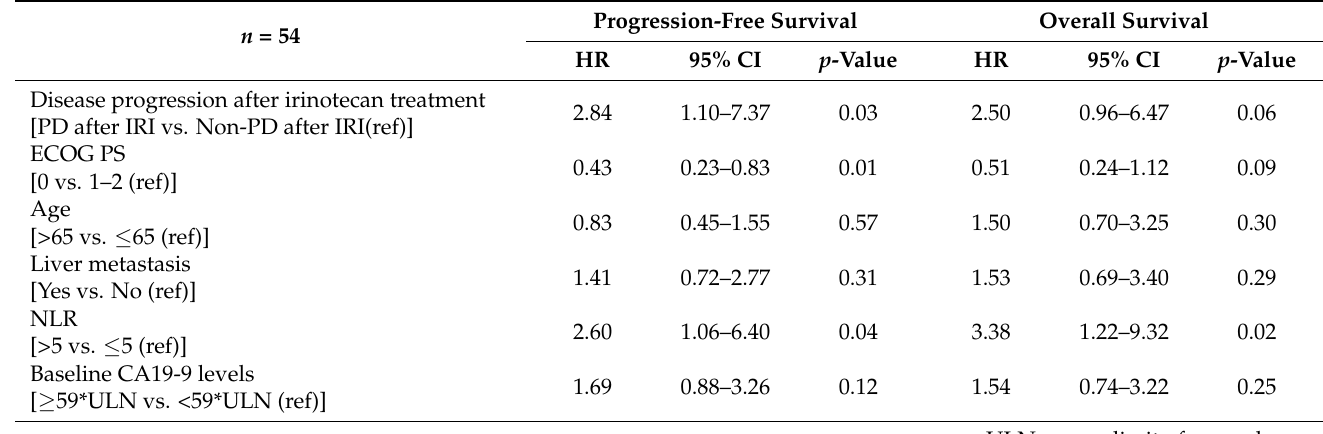
Table 7. Multivariate analysis for PFS and OS in prior-irinotecan analysis set ( n =